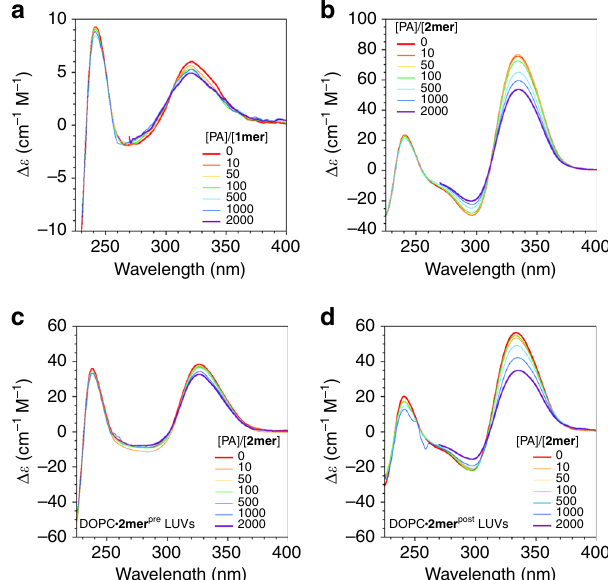
Fig. 3 Characterization of ligand-binding capabilities of multiblock amphiphiles. CD spectra of a 1mer , b 2mer , c DOPC (cid:129) 2mer pre LUVs and d DOPC (cid:129) 2mer post LUVs in HEPES buffer at 20°C upon titration with PA at [PA]/[ 1mer ] = [PA]/[ 2mer ] = 0.0, 10, 50, 100, 500, 1000 and 2000. [ 1mer ] = 14 μ M. [ 2mer ] = 7.0 μ M. Partial spectral curves at [PA]/[ 1mer ] = [PA]/[ 2mer ] = 2000 ( λ <270 nm) are eliminated due to unreliable signals caused by the strong absorption by PA. 20mM HEPES, 50mM KCl, 2.0 mM MgCl 2 , pH 7.5.